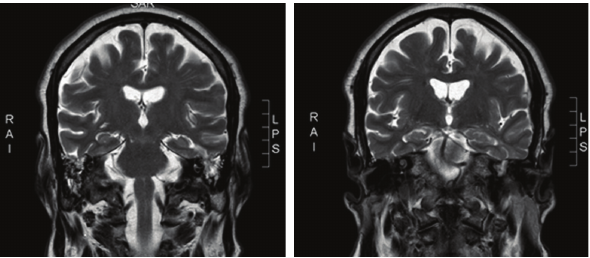
Figure 2: MRI showing areas highly suspicious of herniation. This was confirmed